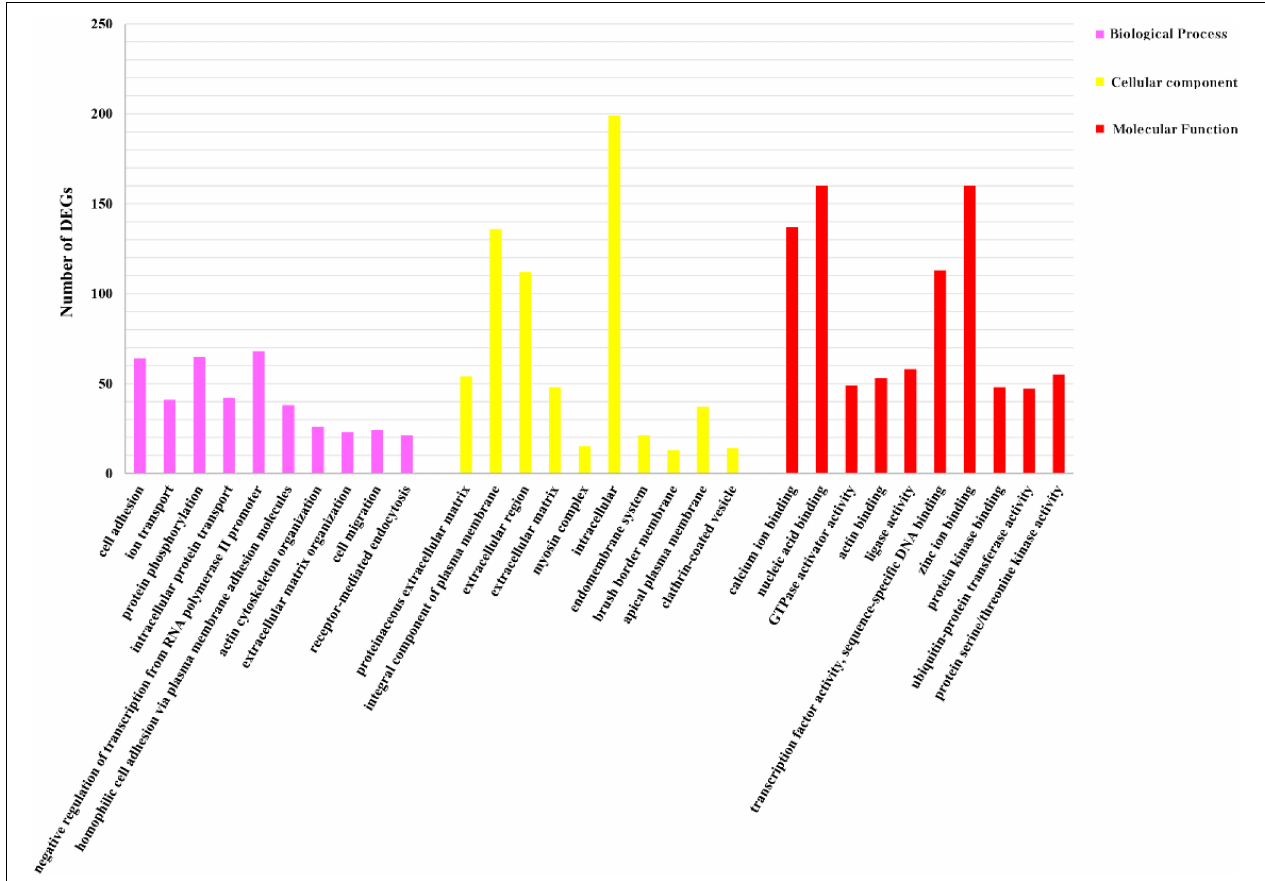
FIGURE 4 | GO analysis of DEGs. Distribution of level-3 GO annotation in three categories. The y -axis represents the corresponding number of DEGs; the x -axis stands for the gene functional classification based on GO.